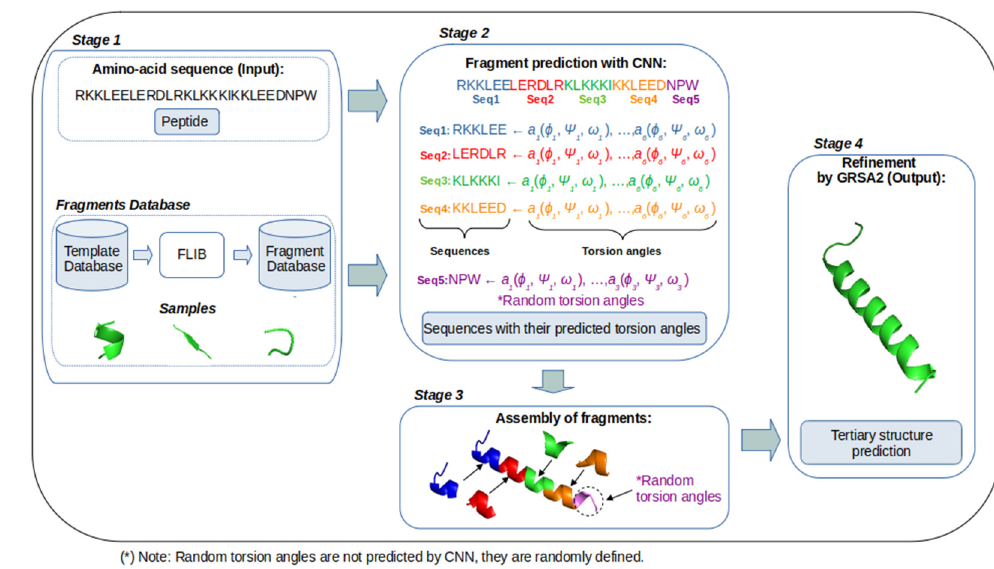
Figure 1. Example of GRSA2-FCNN method for peptide prediction.